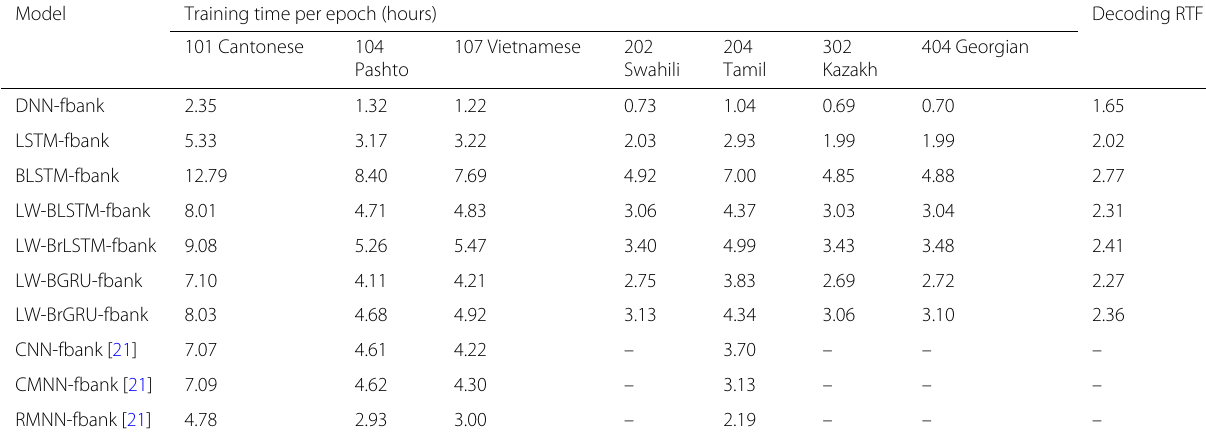
Table 14 Training time per epoch (hours) and decoding real time factor (RTF) of all models for all languages Model